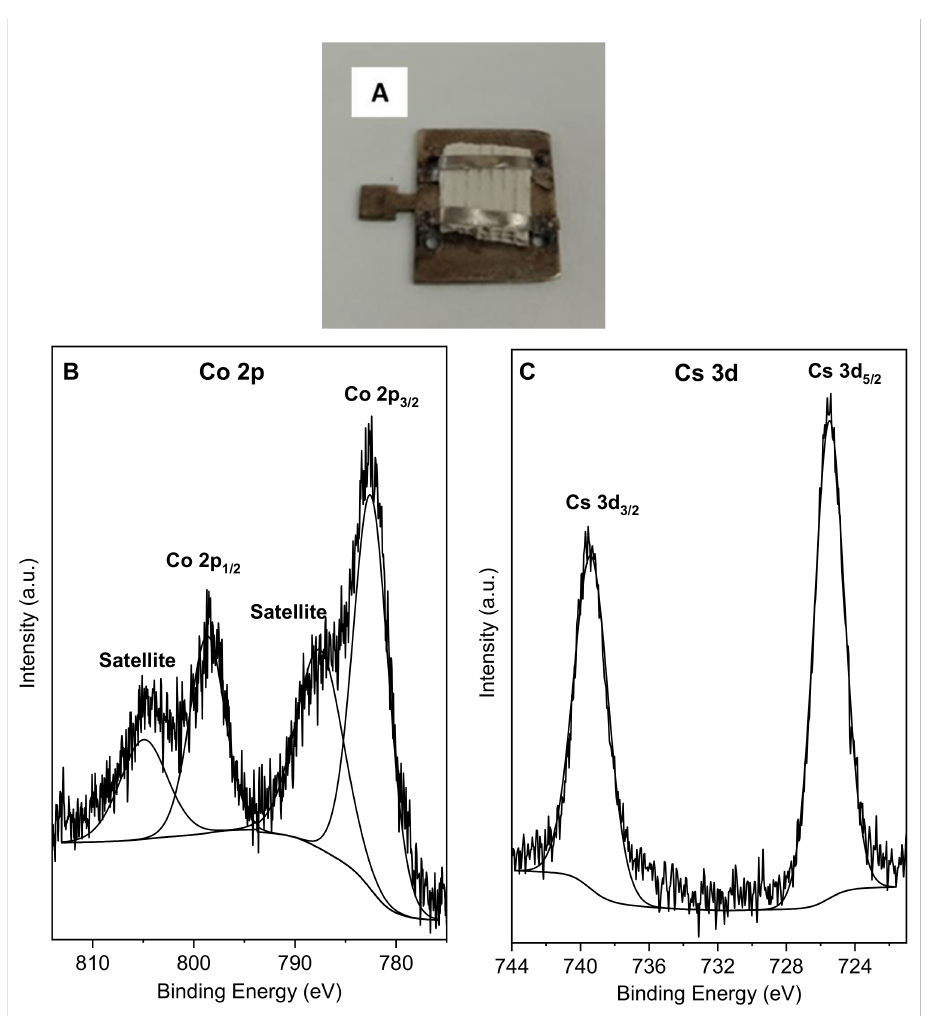
Figure 4. ( A ) Structured sample placed in the XPS holder. Spectra of Cs 2 CoM sample: ( B ) Co 2p and ( C ) Cs 3d core